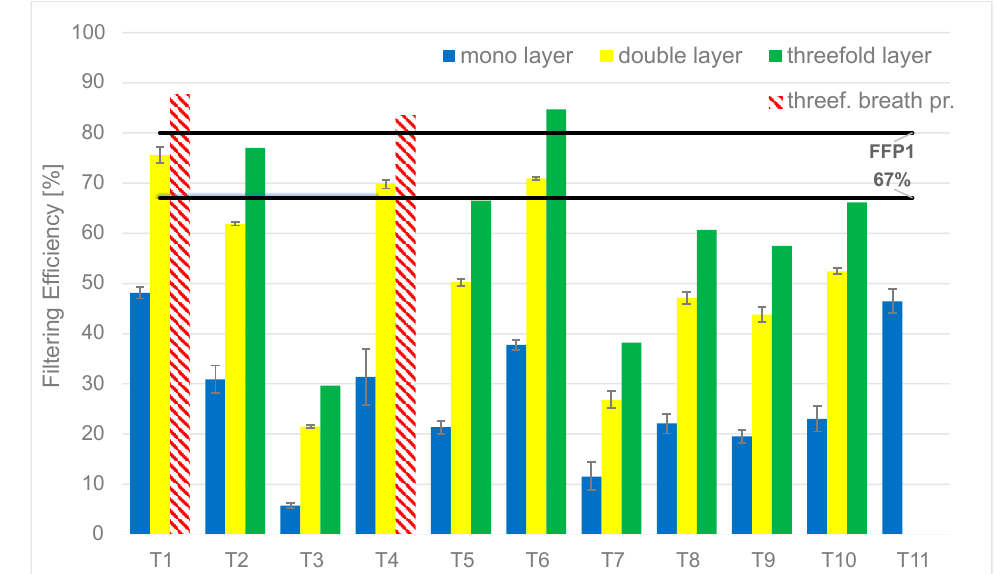
Figure 3. Filtration efficiency of single-, double-, and triple-layer filtration efficiency, where the 67% lower boundary of surgical mask and the higher boundary of FFP1 masks is highlighted. The cross-hatched bars represent the measurements at the upper edge of defined breathability (30 L/min) in triple-layer configurations.